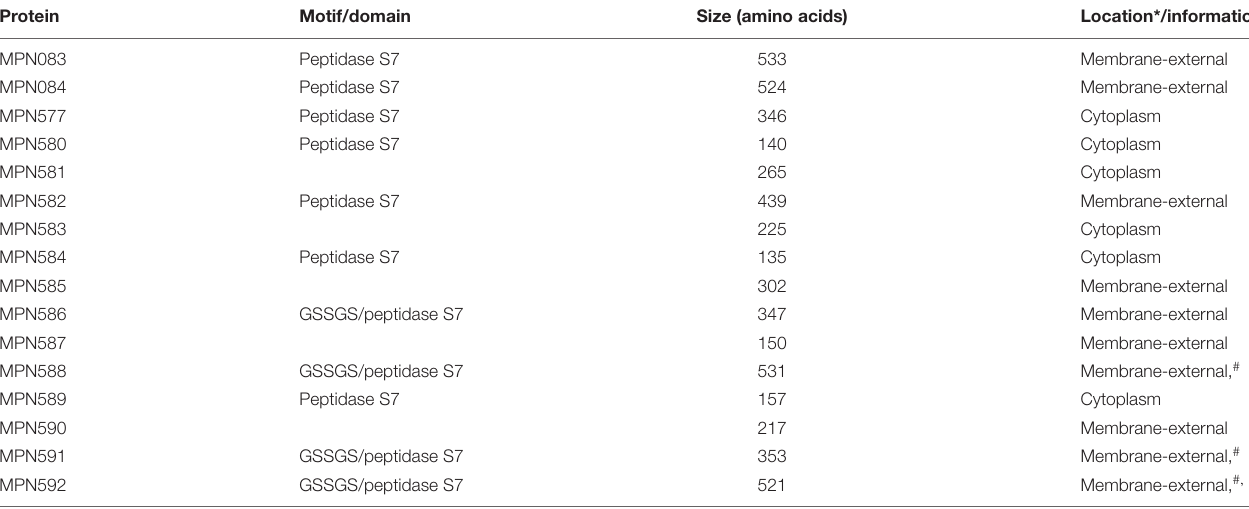
TABLE 1 | M. pneumoniae proteins containing DUF31 domains.